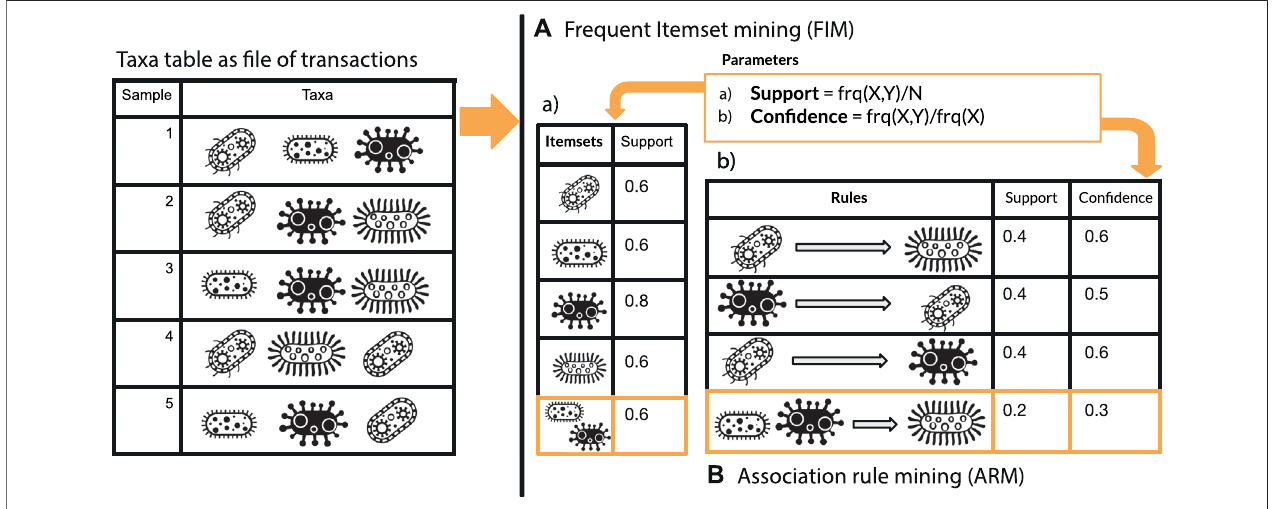
FIGURE1| GraphicaloverviewofFrequentItemset Mining (A) and AssociationRule mining (B) approachintegratedwithelements related tomicrobiome analysis.